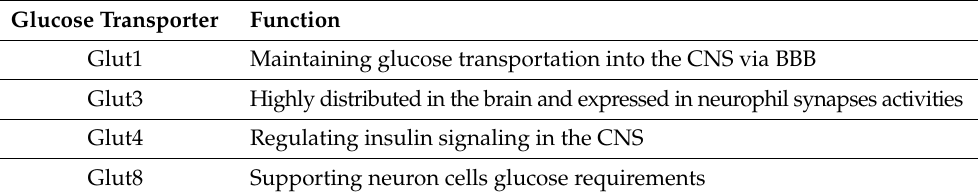
Table 3. Glucose transporters (GLUTs) functions in the brain